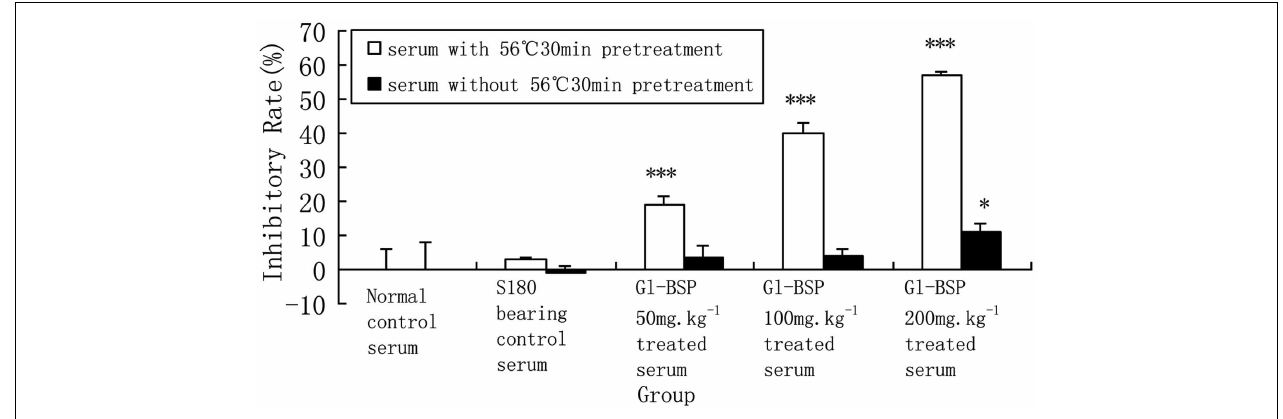
FIGURE 2 | Effect of Gl -BSP-treated serum with or without 30min 56˚C heat pretreatment on proliferation of S180 cells in vitro ( n = 10, ¯ x ± s). * P < 0.05, ** P < 0.01, *** P < 0.001 vs. normal